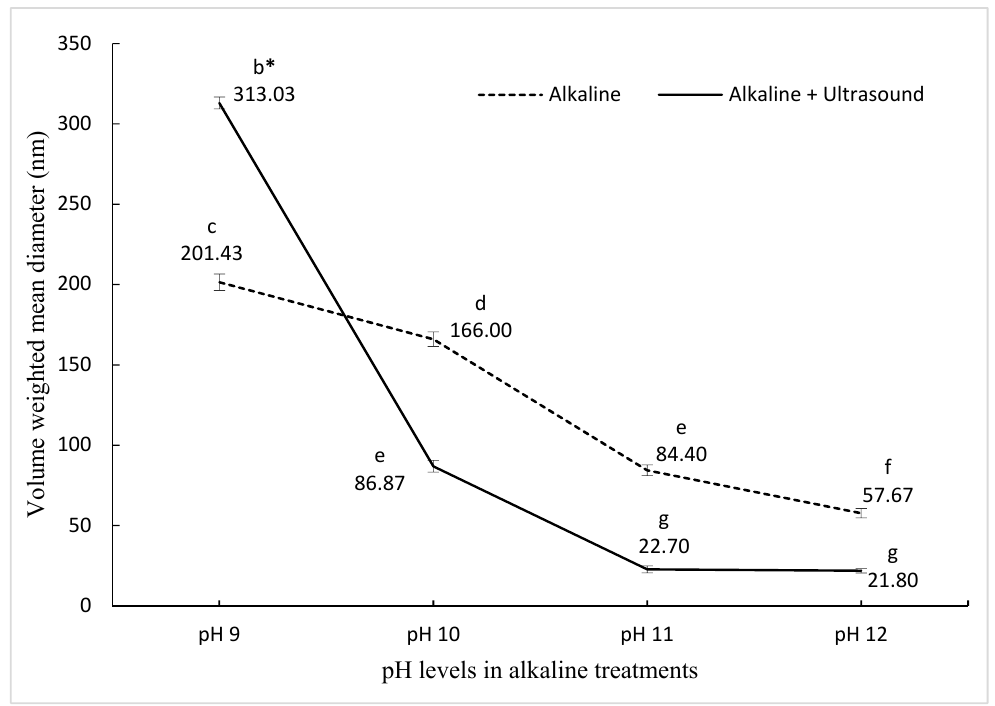
Figure 1. The effect of pH on pea nanoemulsion particle size synthesized using two different treatments. bcdefg Means (± standard deviation) with the same letter are not significantly different ( p ≤ 0.05).